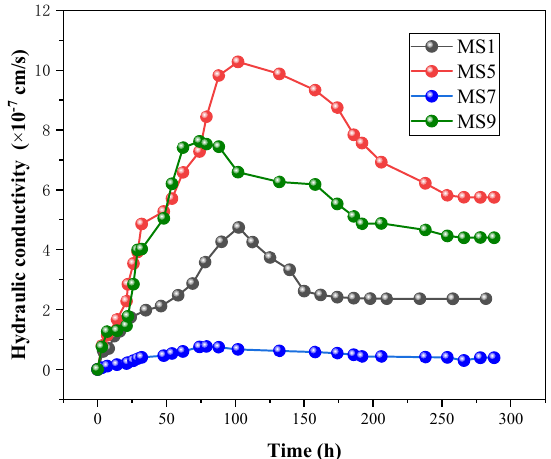
Figure 5. Hydraulic conductivity of modified sludge dredged samples.